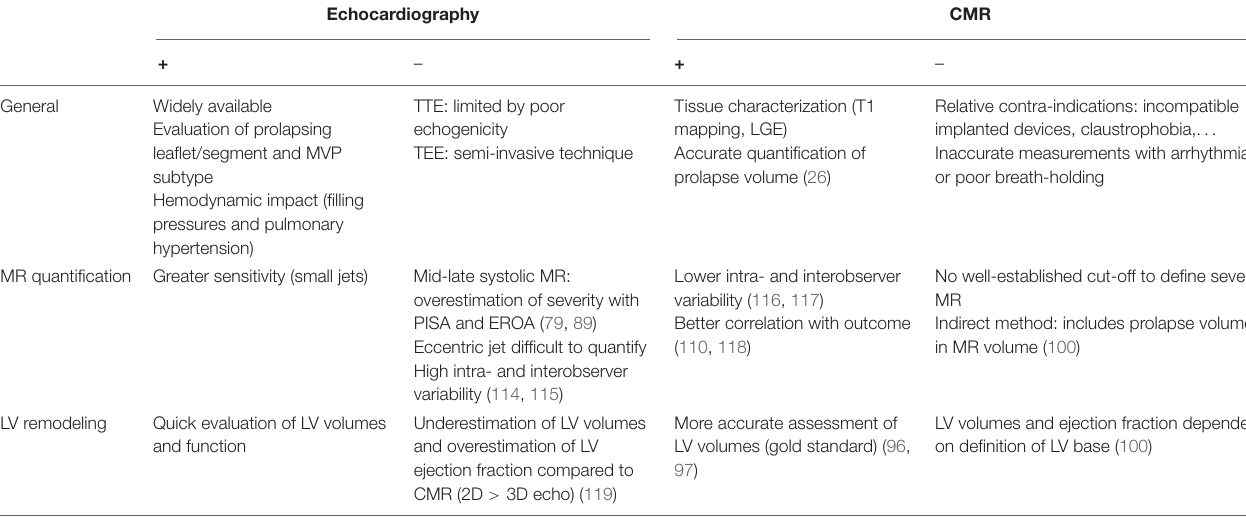
TABLE 1 | Strengths and limitations of echocardiography vs. cardiac magnetic resonance imaging (CMR) in the assessment of mitral valve prolapse. Echocardiography